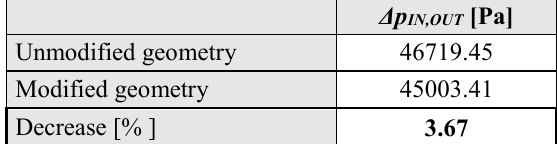
Table 4. Evaluation of Δp IN,OUT ( η =1 Pa . s), percentage